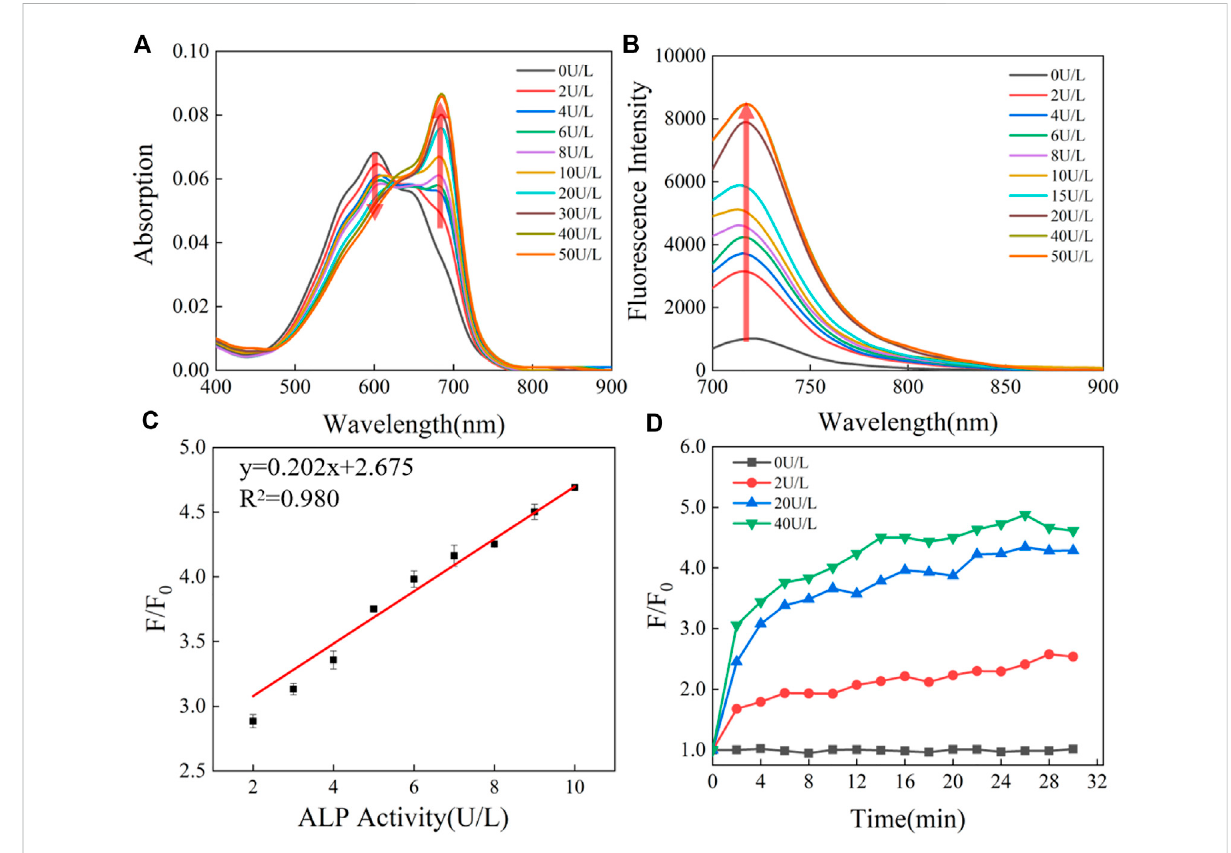
FIGURE 2 (A) Absorption and (B) emission spectra of 5 μ M CS-ALP in the presence of different concentrations of ALP. (C) Calibration curves. (D) Fluorescence intensity at 716 nm vs . the reaction time with varying levels of ALP activity. The tests were carried out in aqueous solution (5%